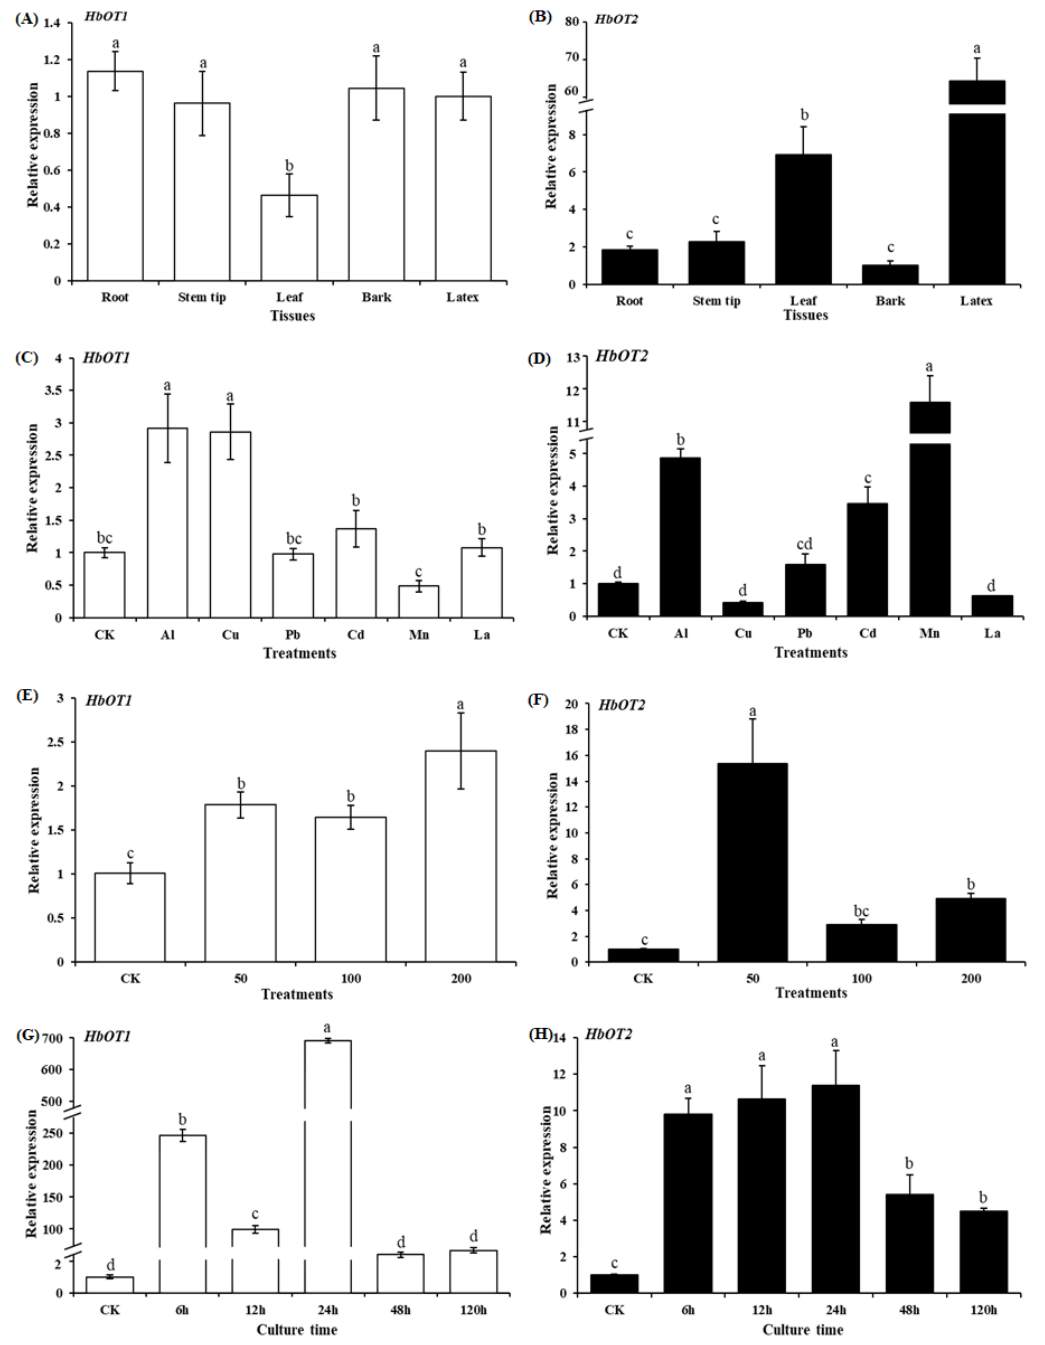
Figure 5. Analysis of HbOT1 and HbOT2 expression patterns. ( A , B ) qRT-PCR analysis of the HbOT1 and HbOT2 transcripts in different tissues of “Reyan 7-33-97” rubber tree saplings. ( C , D ) qRT-PCR analysis of HbOT1 and HbOT2 under different metal ion stresses. The two-whorled leaf tissue-cultural rubber tree saplings were hydroponically treated with 200 mmol/L AlCl 3 · 6H 2 O, CuSO 4 · 5H 2 O, PbCl 2 , CdCl 2 , MnSO 4 · H 2 O, and LaCl 3 · 7H 2 O, respectively for 120 h. ( E , F ) qRT-PCR analysis of HbOT1 and HbOT2 in the root of “Reyan 7-33-97” rubber tree saplings under different concentrations of aluminum stresses. ( G , H ) qRT-PCR analysis of HbOT1 and HbOT2 in the root of “Reyan 7-33-97” rubber tree saplings under aluminum stresses for different time durations. The relative expression values of HbOT1 and HbOT2 are given as means ± SE ( n = 3). The experiments were performed with at least three independent biological replicates. Different letters indicate significant difference among treatments at p <